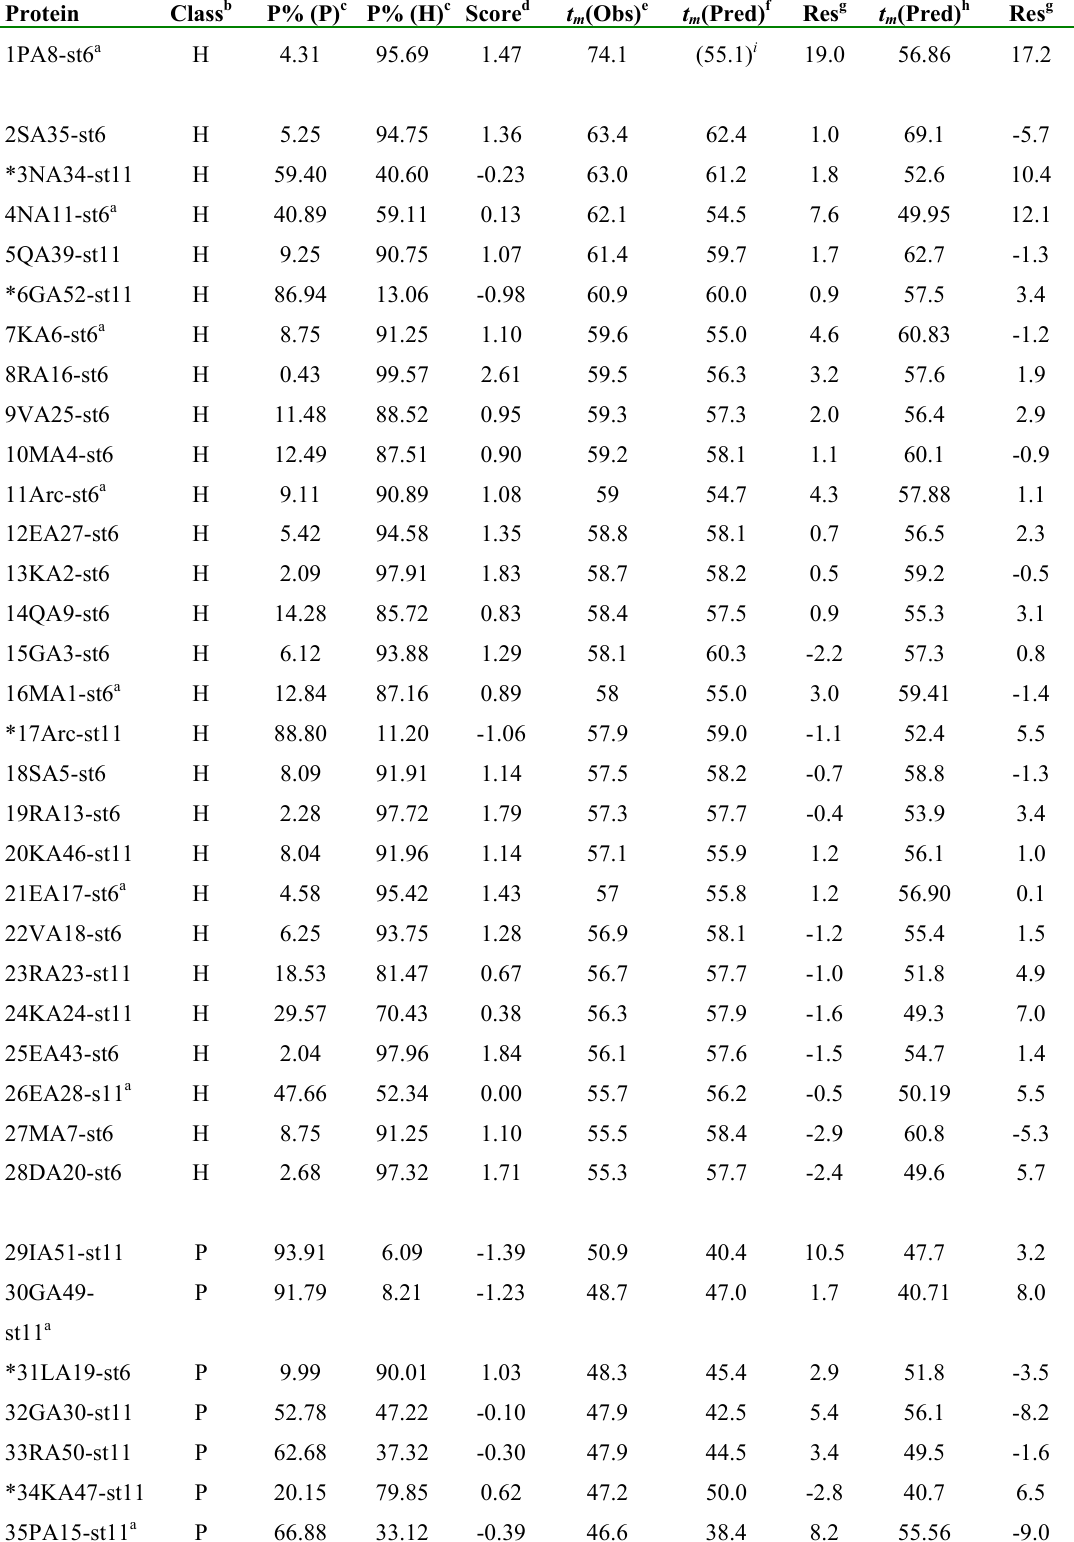
Table 1. Results of the ADL, PLR and LMR Analyses of the Arc A-Mutants in the Training and Test